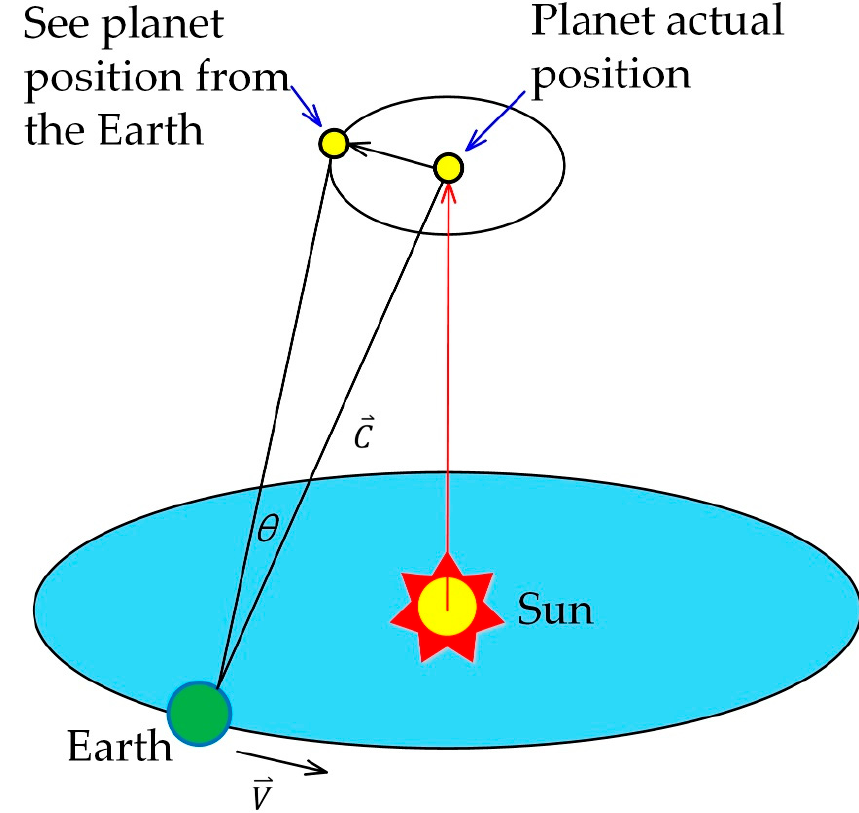
Figure 6. Relationship diagram of sun, earth, and planet.